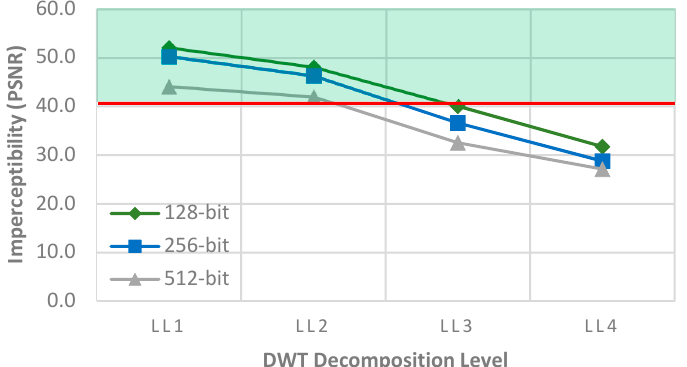
Figure 2. Trade-off between imperceptibility and embedding capacity in various LL sub-bands.